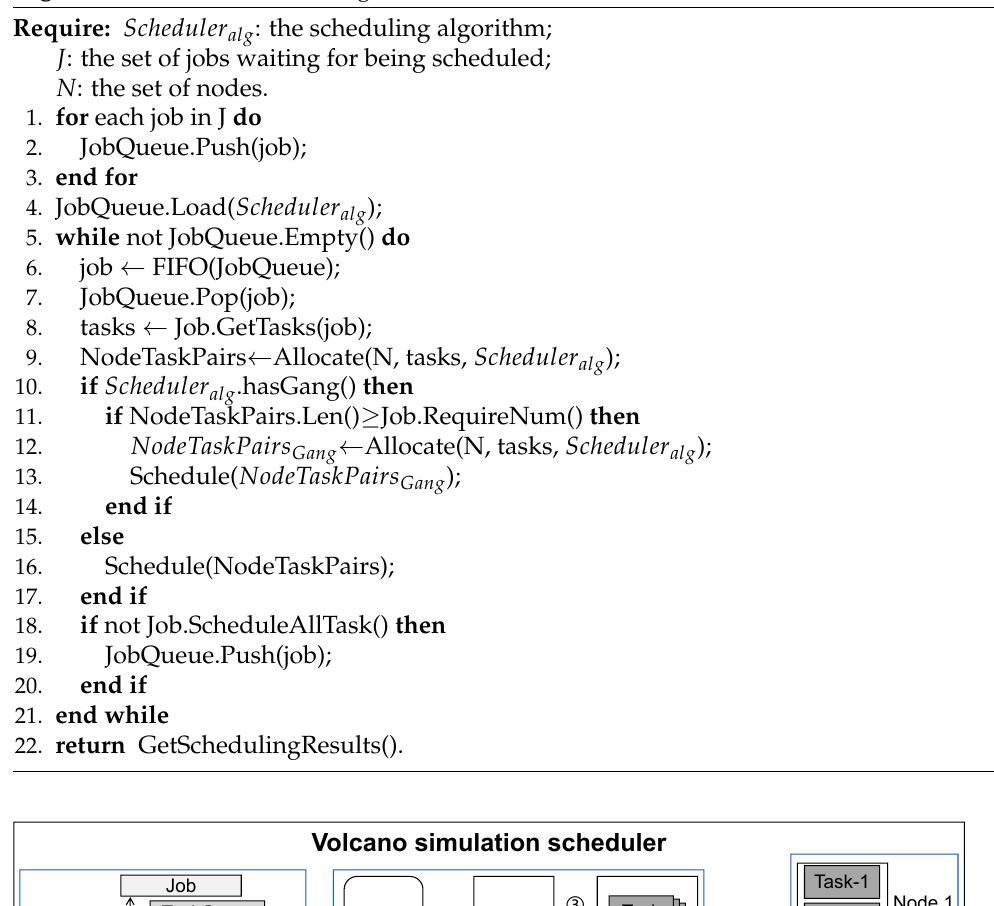
Algorithm 2 Volcano scheduling simulation.